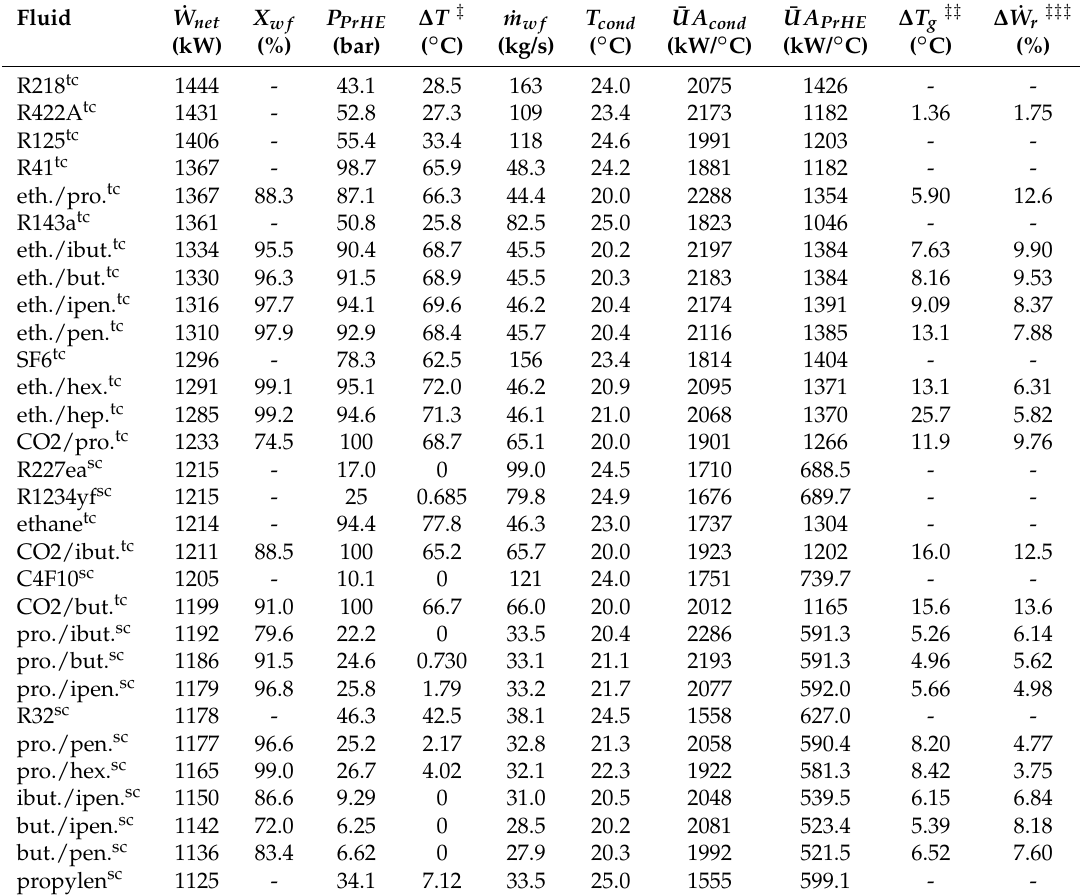
Table 4. Fluid selection and optimization based on fixed values of the minimum pinch point